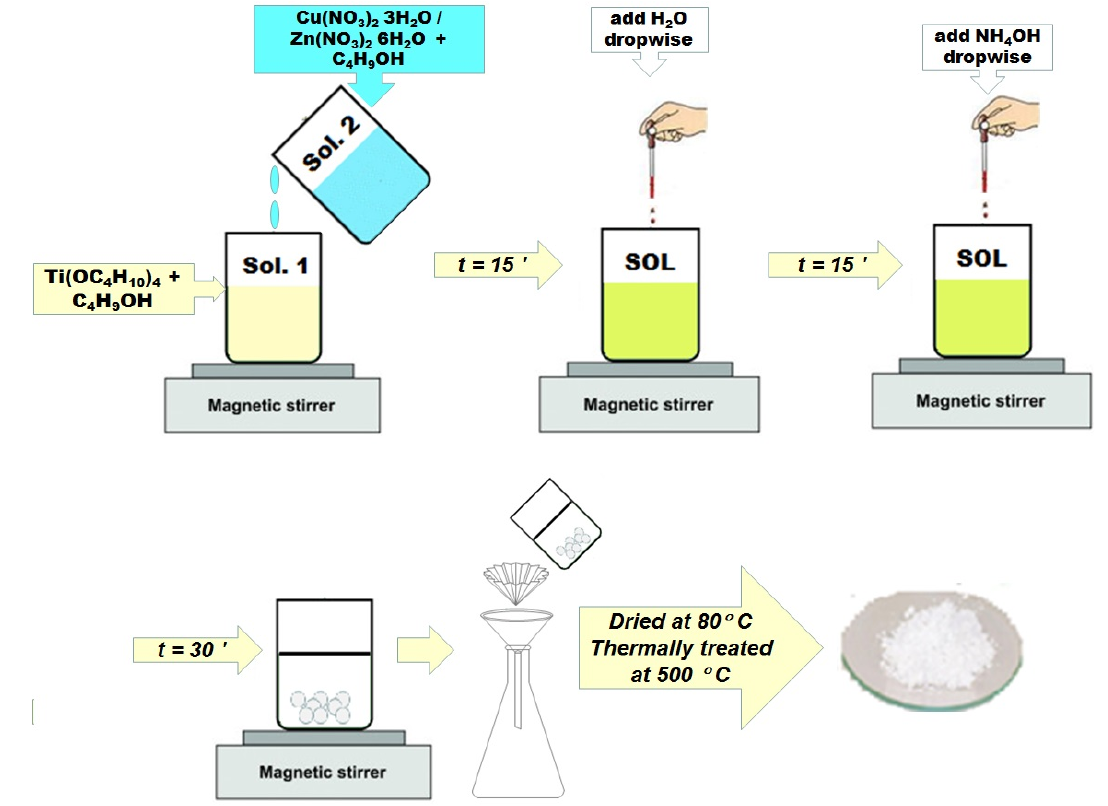
Figure 16. The flowchart of the sample preparation by sol-gel method. Table 7. The composition of the solution and the experimental parameters of the sol